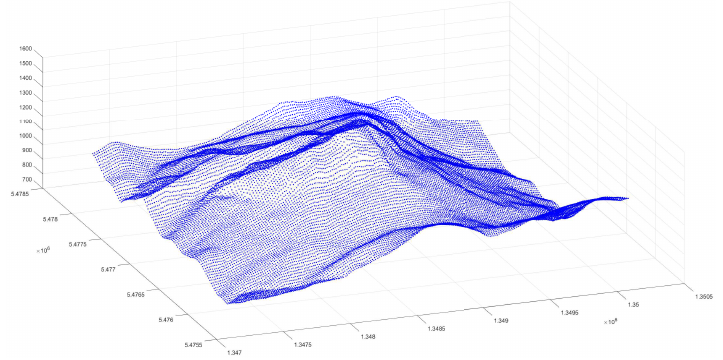
Figure 15. The data of the Mount Velky